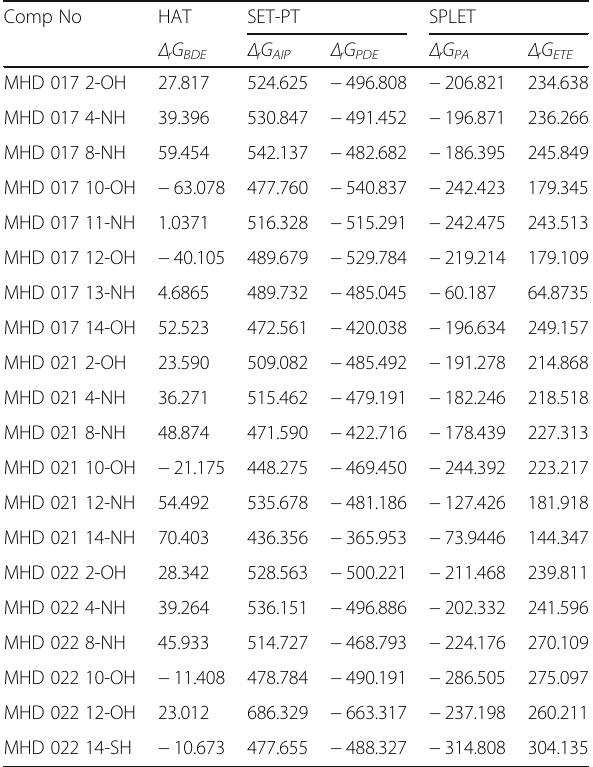
Table 4 The reaction Gibbs free energy ( Δ r G in kJ/mol) of scavenging CH 3 OO· radical by hydrazone antioxidants at the B3LYP/6-311G* level in a